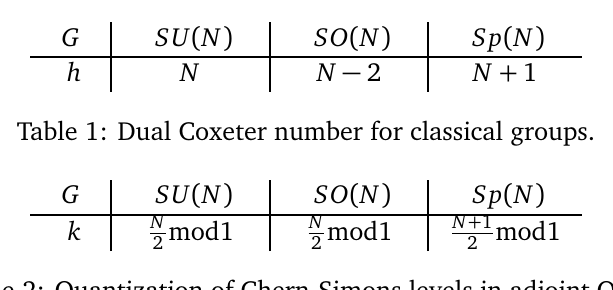
Table 2: Quantization of Chern-Simons levels in adjoint